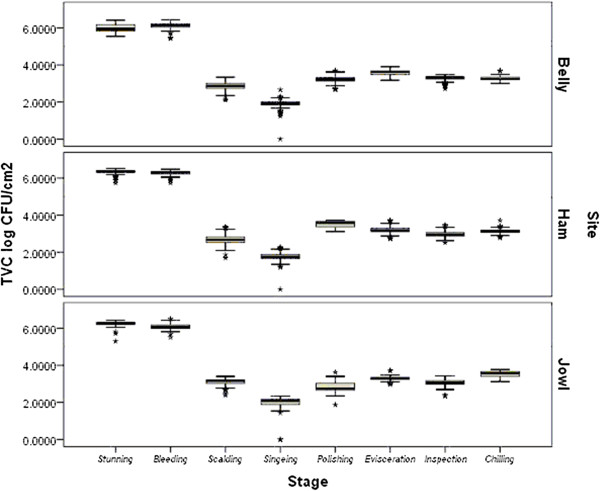
TVC counts (log cfu/cm2) on jowl, belly and ham at different stages of the slaughter process. Broken line indicates TVC limit according to the performance criteria of Regulation (EC) No 2073/2005.